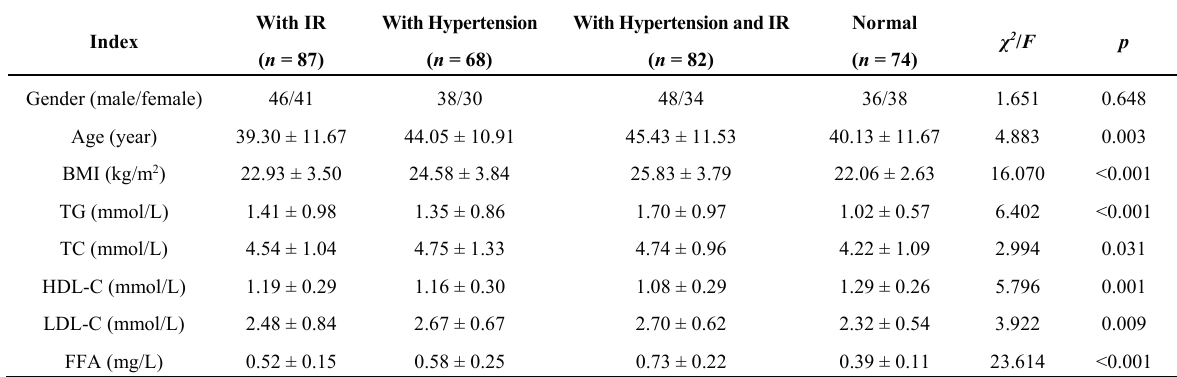
Table 2. Index comparisons among the four